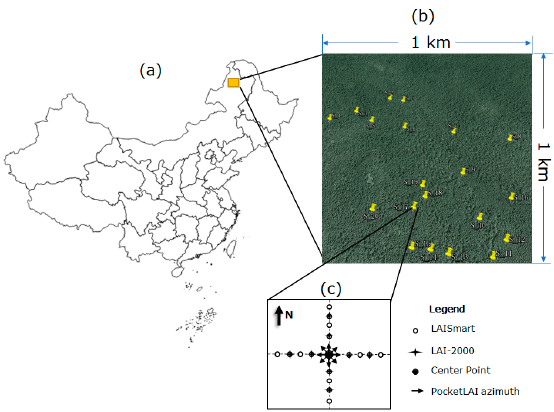
Figure 1. The research area (yellow square) located in China ( a ); the ESU (yellow symbols) distributed